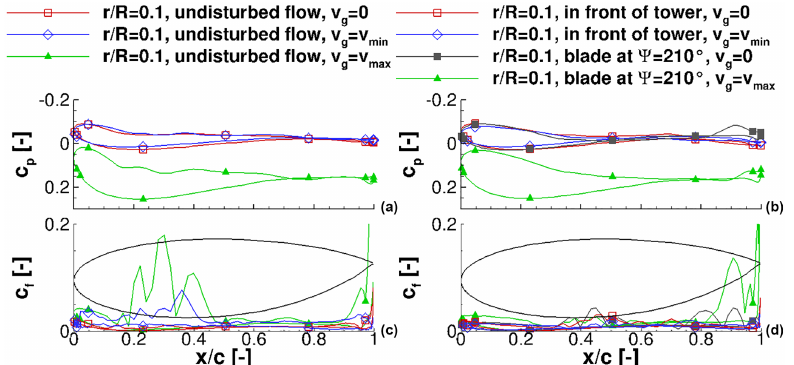
Figure 8. Pressure distribution of the blade at the inboard section, (a, c) undisturbed flow, and (b, d) with tower blockage; (a, b) pressure distribution and (c, d) friction force coefficient.